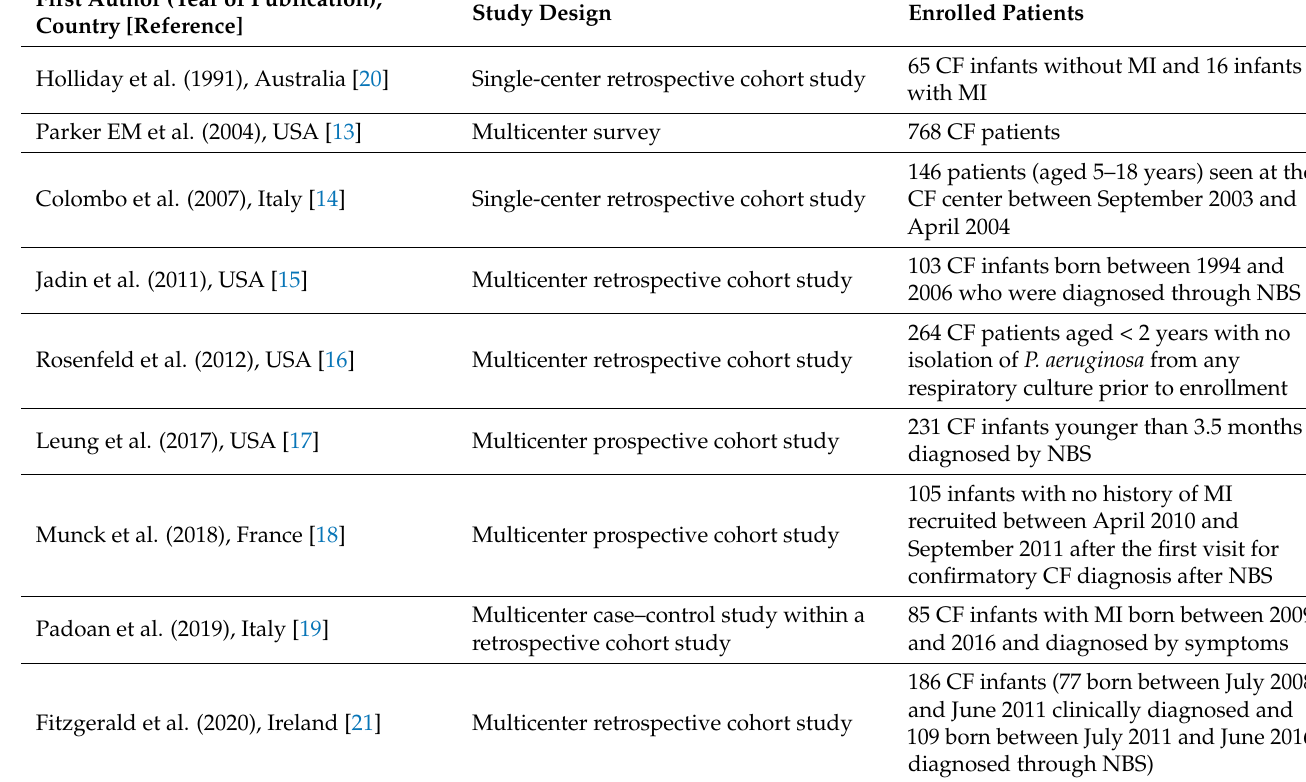
Table 1. Summary overview of the selected studies.